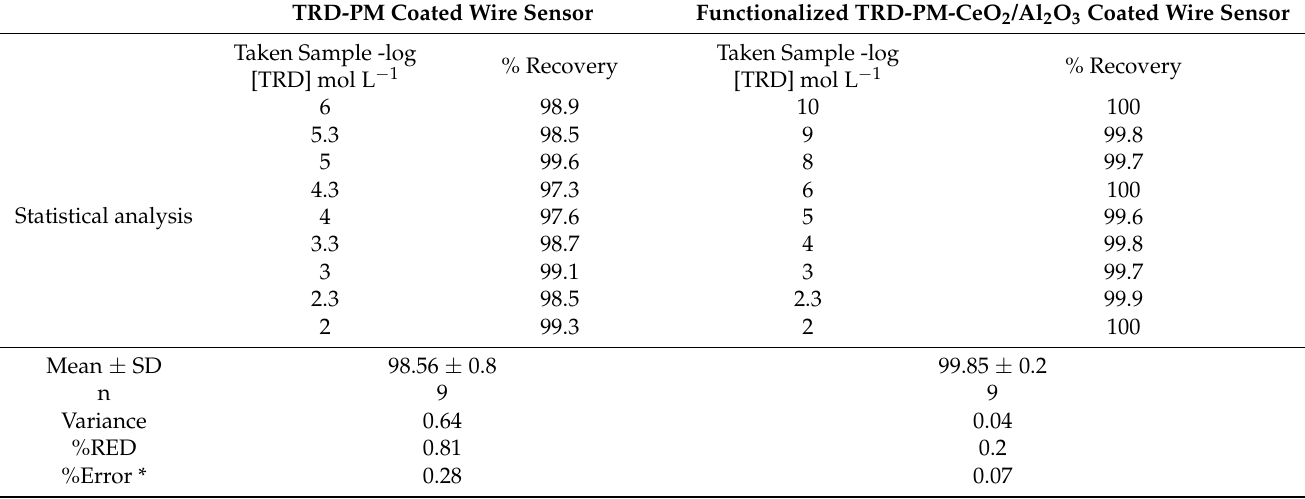
Table 4. Accuracy results of the analysis of TRD samples using conventional and functionalized TRD-PM and TRD-PM-CeO 2 /Al 2 O 3 nanocomposite coated wire